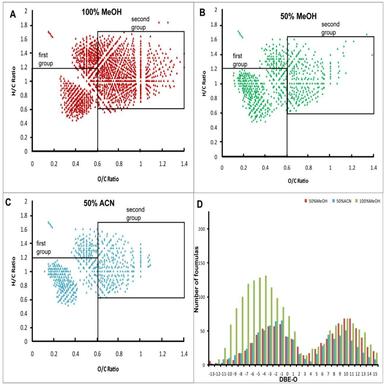
Van Krevelen diagrams for molecular formulas obtained in NOM by ESI-FTICR-MS using different spray solvents; (A) 100% MeOH as spray solvent; (B) 50% MeOH aqueous solution as spray solvent; (C) 50% ACN aqueous solution as spray solvent; Number of formulas as a function of DBE-O value for NOM CHOS-molecules (D).